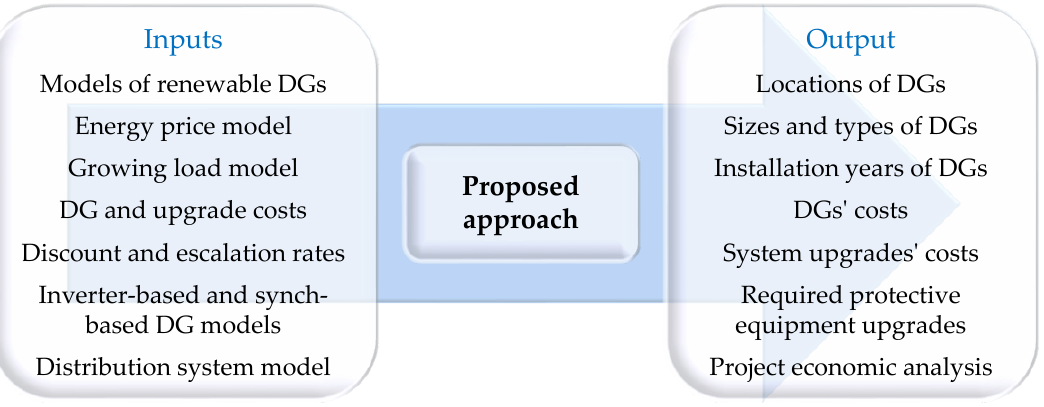
Figure 1. Proposed methodology Figure 1 . Proposed methodology structure.